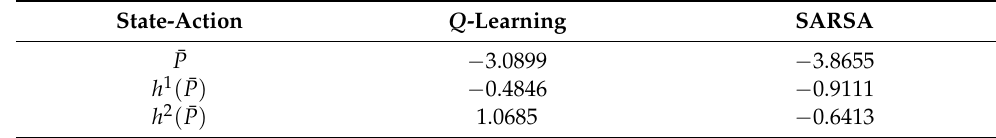
Figure 9. Comparisons of Q -values between two algorithms. ( a )Optimal policy for the sensor; ( b ) Optimal policy for the attacker; ( c ) Nash equilibrium policy for sensor and attacker. Table 7. Comparison of optimal strategy Q -values from the perspective of the